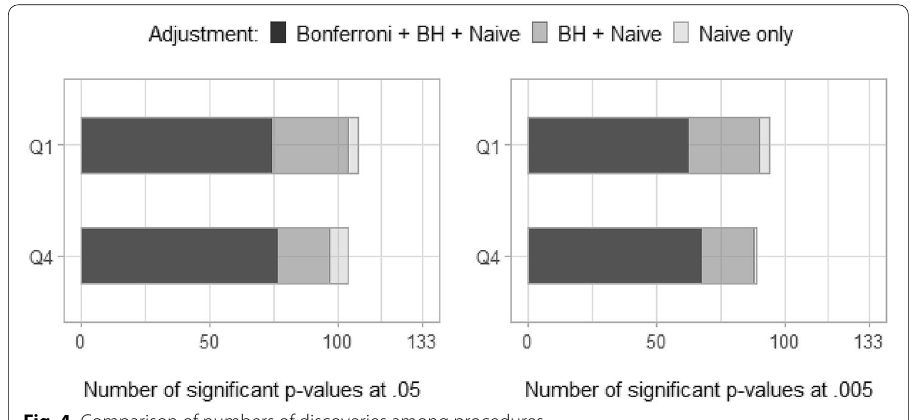
Fig. 4 Comparison of numbers of discoveries among